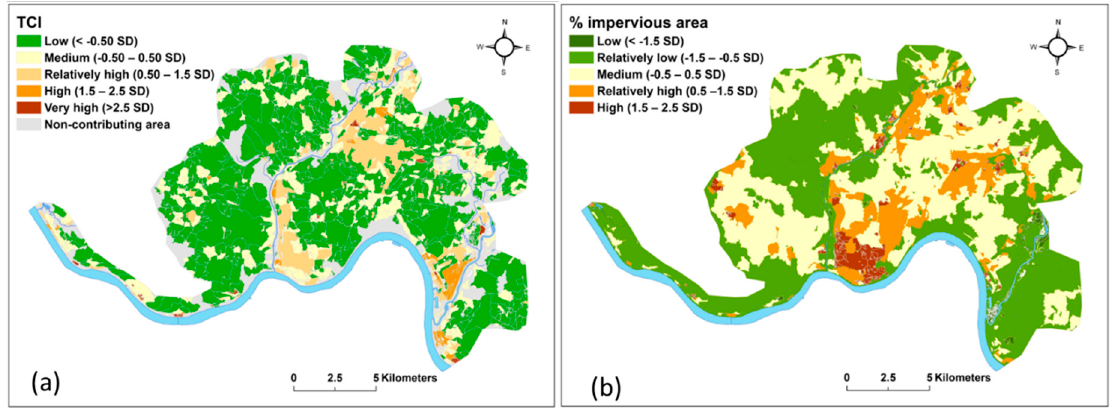
Figure 3. Results of TCI ( a ) and impervious area ratio ( b ).